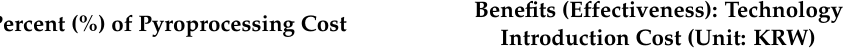
Table 9. Benefits of pyroprocessing.